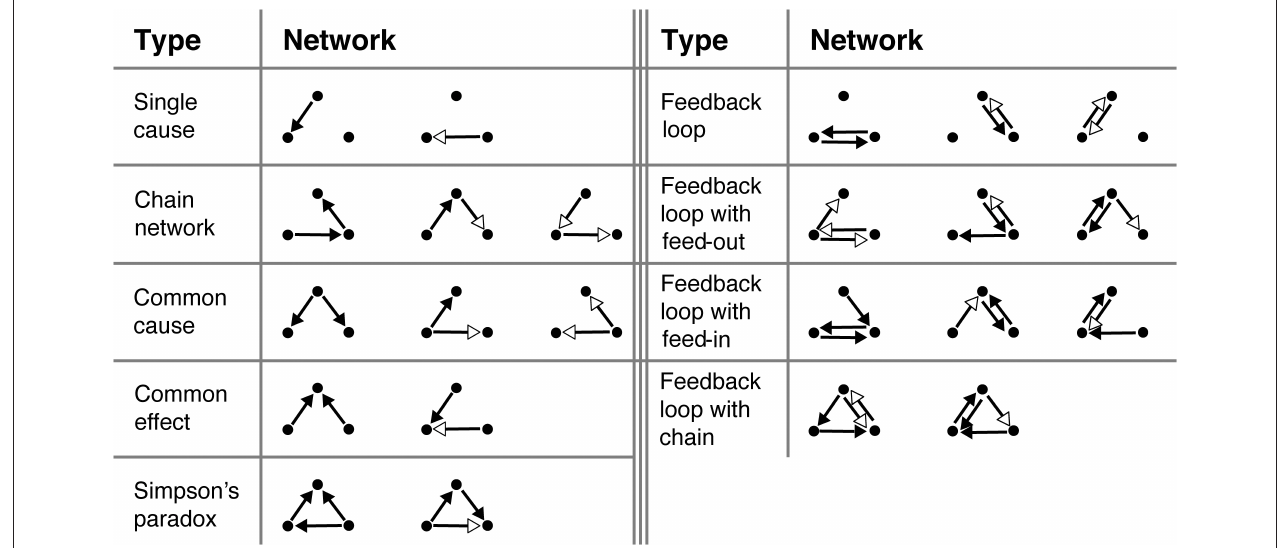
FIGURE 5 | All 23 structures participants were tasked with learning. Black arrowheads signify “regular” connections ( θ = 1), white arrowheads signify “inverse” connections ( θ = −